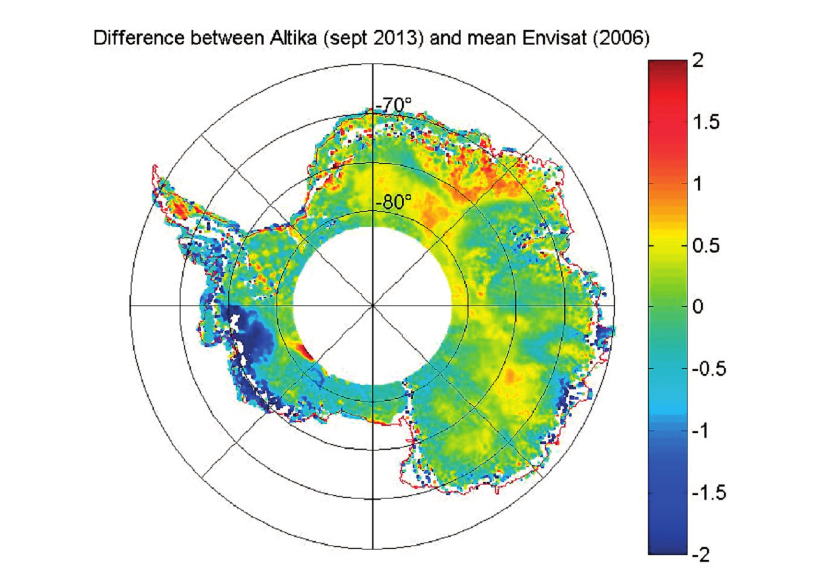
Figure 8. Mean elevation difference between SARAL/AltiKa and ENVISAT in 2006 in